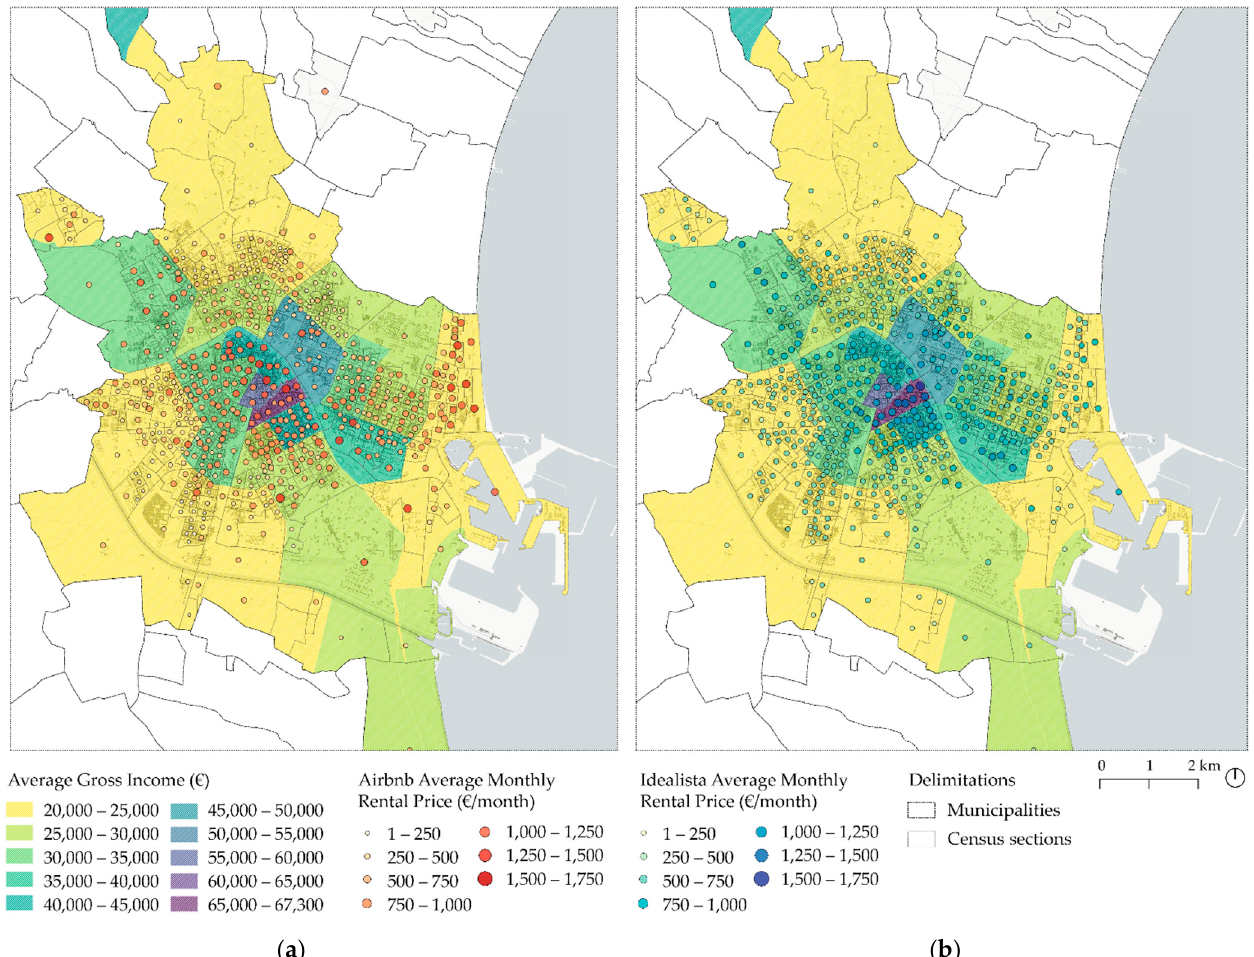
Figure 12. Average gross income and properties’ monthly rental price for ( a ) Airbnb and ( b ) Idealista.